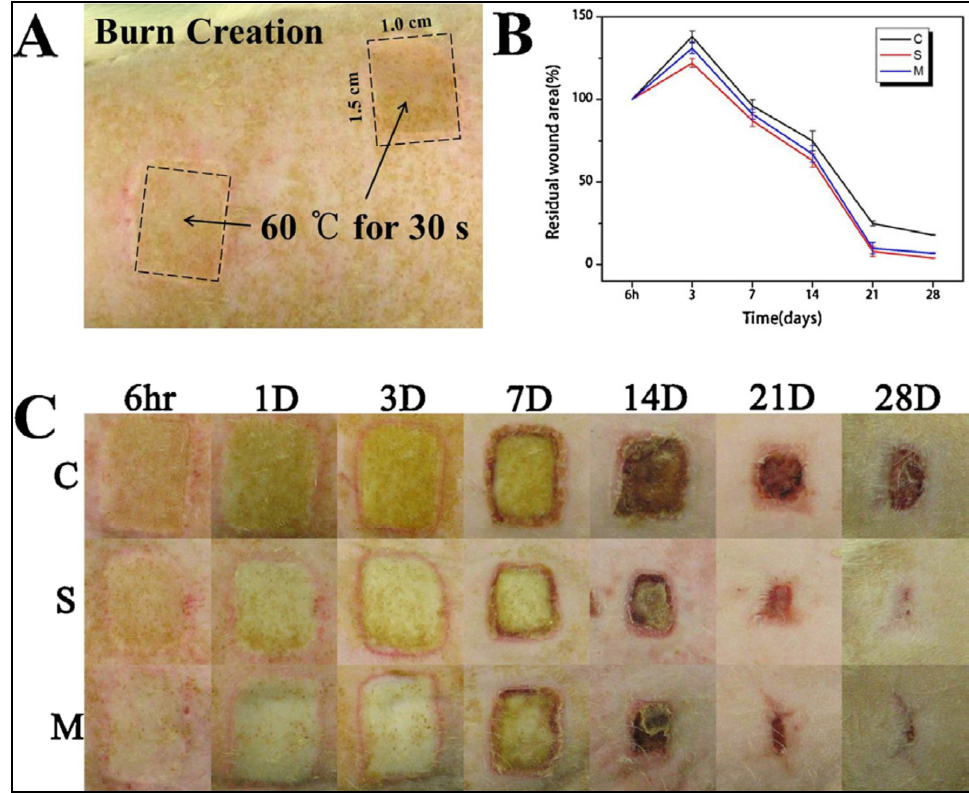
Figure 8. ( A ) Burn wound area on rat skin right after the creation. ( B ) Residual wound area change with healing time (28 days). ( C ) Gross findings of wound area treated with different wound dressing materials (C: medical gauze, S: SF nanomatrix, and M: Medifoam ® ) (scale: 50 µ m). Reprinted with permission from reference